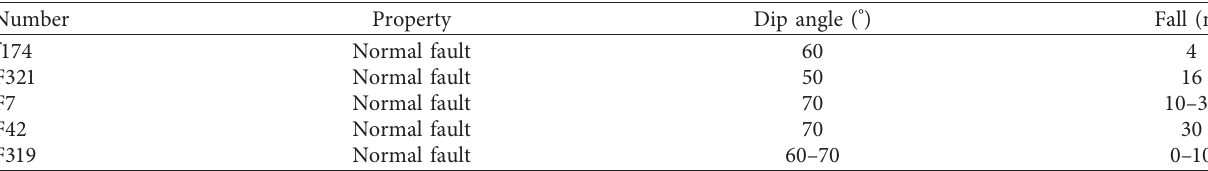
Table 1: Fault parameters.